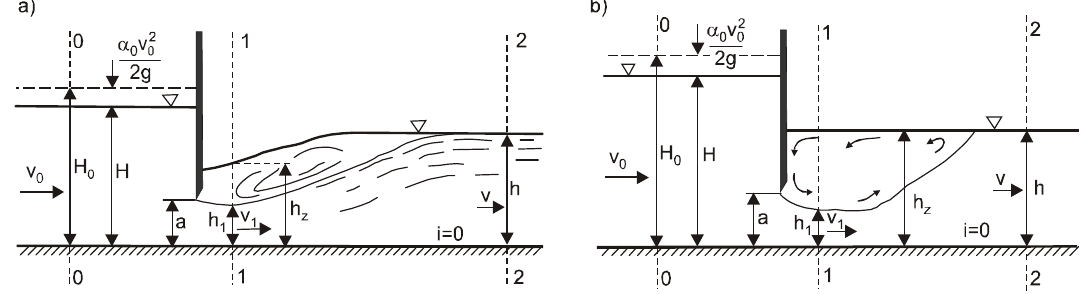
Figure 1. Submerged flow under the gate: ( a ) water depth h z immediately downstream of the gate is noticeably lower than the downstream water depth h (h z < h), ( b ) the tailwater curve is always above the jump curve (h z ≈ h).